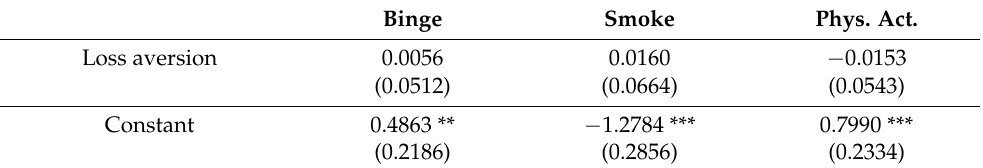
Table A3. Regression results with fewer control variables, Korean sample. ***, ** denote significance levels of 1%, 5%, respectively.